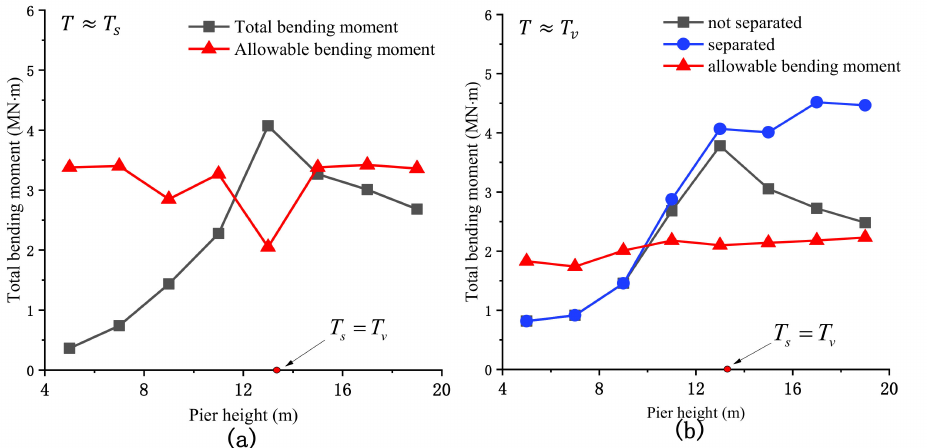
Figure 11. The destruction of the bottom of the pier at different pier heights: ( a ) total bending moment and allowable bending moment of the pier’s base when T ≈ T s ; ( b ) total bending moment and allowable bending moment of pier’s base when T ≈ T v